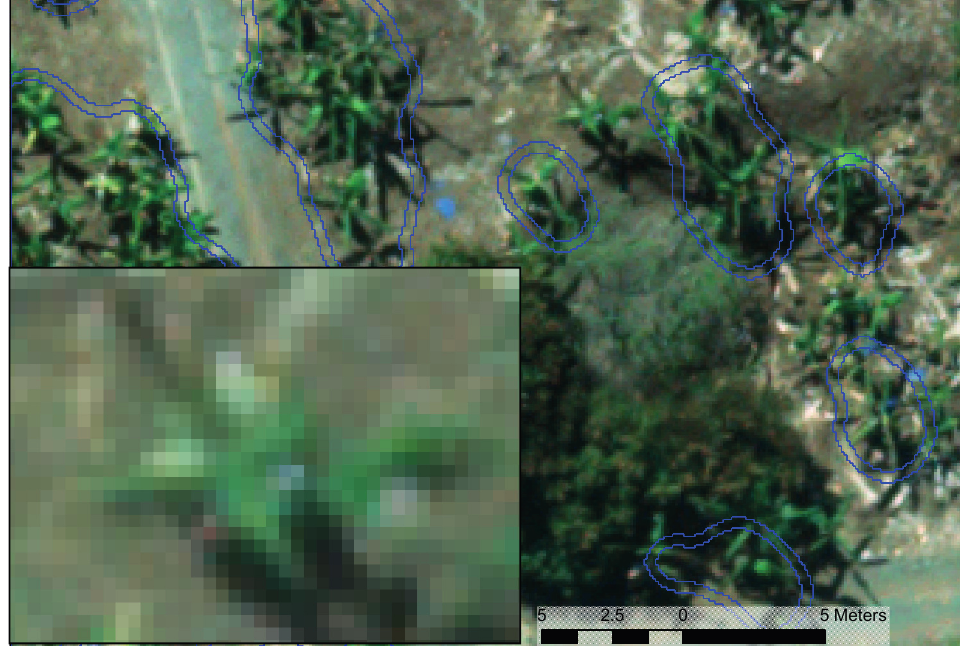
Figure 11. Individual banana plant with limited contrast against the ground. Location: 152°53 ′ 50 ″ E, 26°41 ′ 25 ″ S.